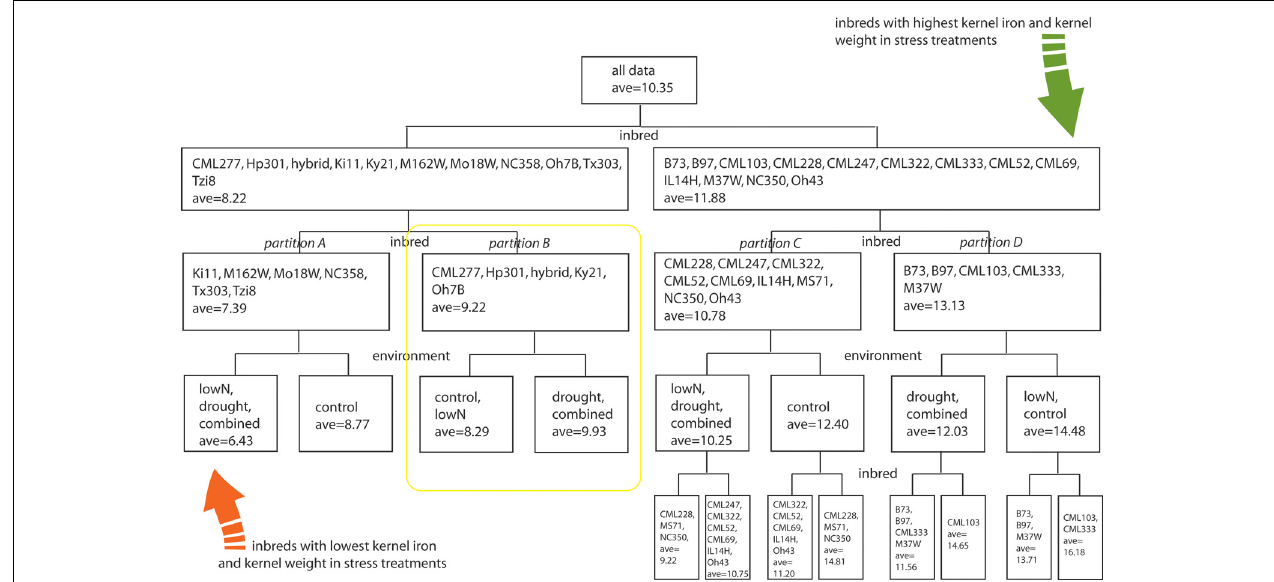
FIGURE 3 | Multivariate partition analysis of inbred and environmental treatment factors important for kernel iron concentration. Combined response variables representing kernel Fe concentration and weight from each genotype were partitioned into subclasses defined by either inbred or environmental treatment conditions. Partitions were used to maximize differences in the combined Fe-weight response variable, leading to hierarchical splitting of genotype-treatment combinations until response variables were no longer considered significantly different among partition